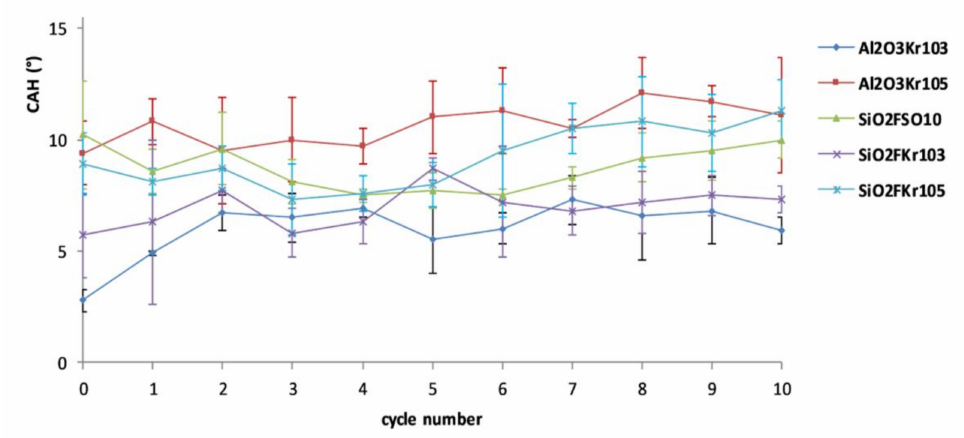
Figure 11. CAH vs. frost/thaw cycle number. Standard deviations are reported as error